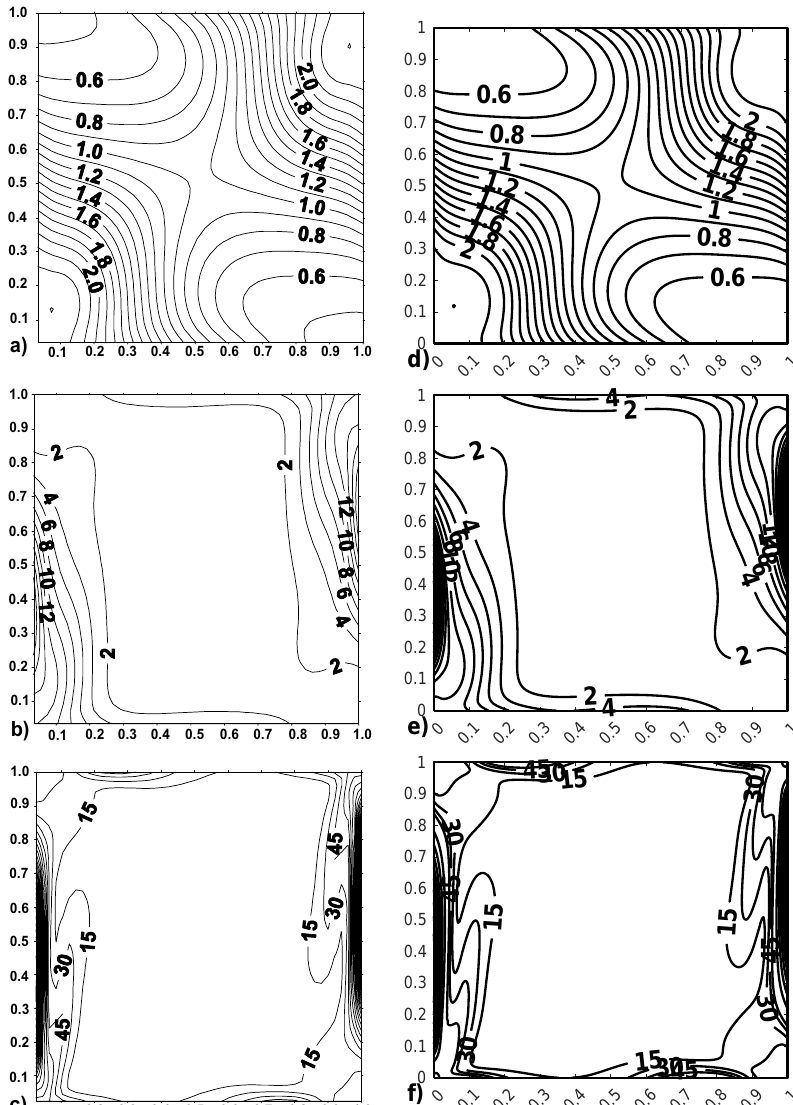
Fig. 12. Entropy generation maps due to heat transfer and fluid Figure 2. Comparison of total entropy contours in a NC flow problem. ( a – c ) Reference [26] (the left); friction for irreversibility distribution ratio u 10 " 4 : (a) ¼ ( d – f ) Present (the right with N = 51). Ra 10 3 , (b) Ra 10 4 and (c) Ra 10 5 . ¼ ¼ ¼